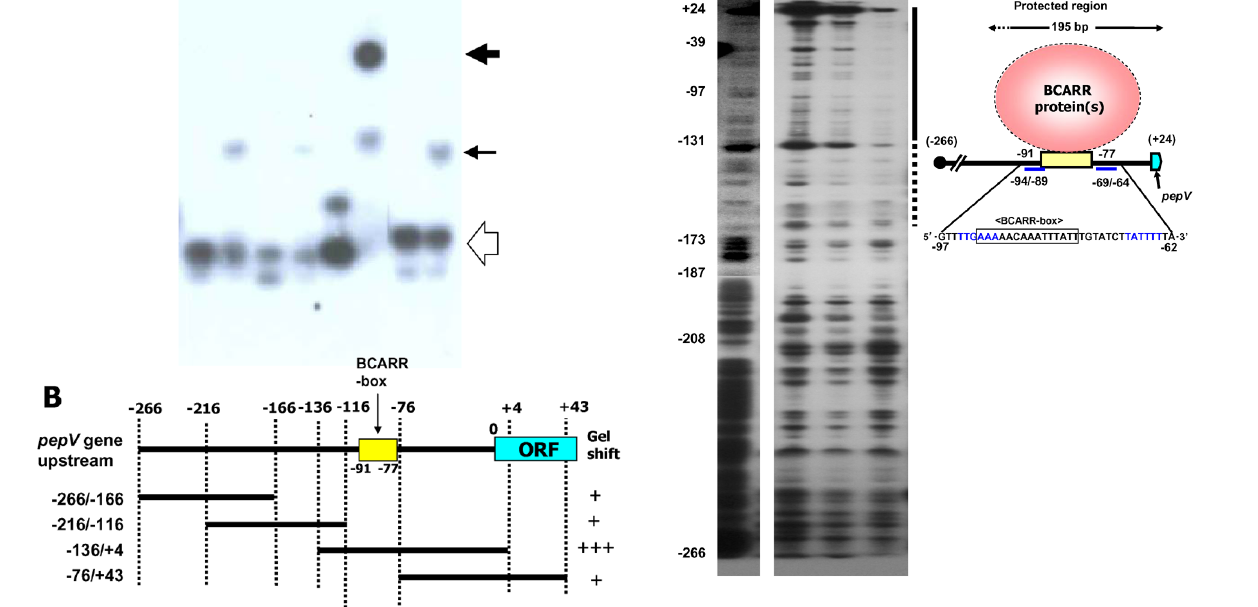
Figure 6. DNase I footprinting analysis and schematic drawing of the BCARR protein-DNA binding. Single-end (forward 5 9 strand) radioactively labeled probes containing 290 bp of sequence upstream of pepV were examined alone (lane 1) or with 2.3 m M (lane 2) and with 18 m M (lane 3) BCARR protein (A). Lane AG; A + G ladder prepared from the labelled DNA as described in Materials and Methods. The numbers at the left indicate the nucleotide number from the start codon. The vertical bar at the right represents the protected region. Solid lines and dotted lines indicate strongly and weakly protected regions, respec- tively. Schematic drawing of the DNaseI footprint analysis (B). The binding site of the BCARR protein was located in the sequence upstream of the pepV gene. The consensus motif detected in the upstream sequences of the six proteolysis genes ranging from 2 91 to 2 77 in pepV gene is shown by a yellow box. The putative promoters, 2 35 (TTGAAA) and 2 10 (TATTTT), are underlined and in blue letters. The nucleotide numbers indicate the distance from the start